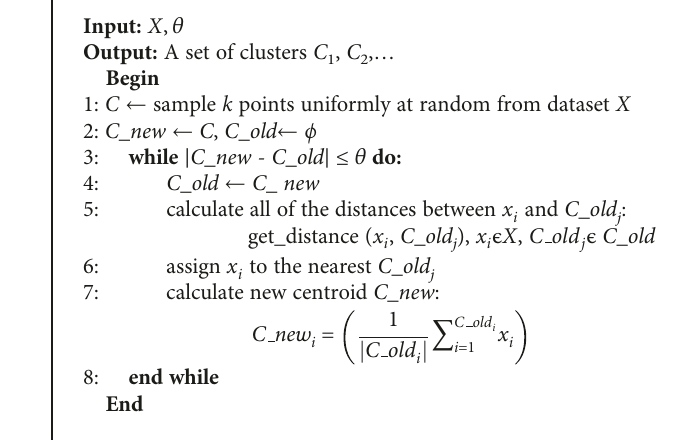
Algorithm 1: ( K -means algorithm).